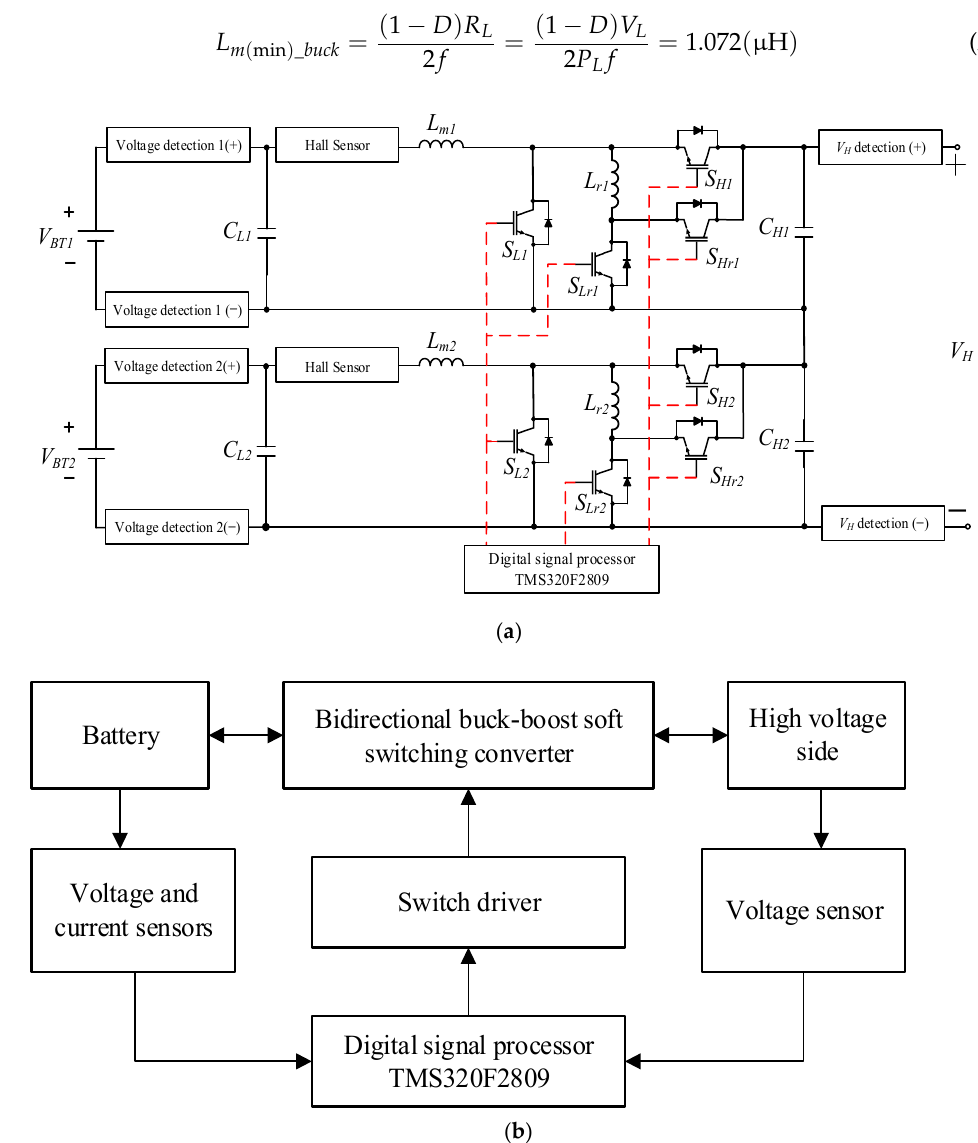
Figure 4. An energy storage system with uniform charge/discharge control: ( a ) circuit architecture; ( b ) block diagram. Table 1. The electricity specification of the bidirectional buck–boost soft-switching converter.